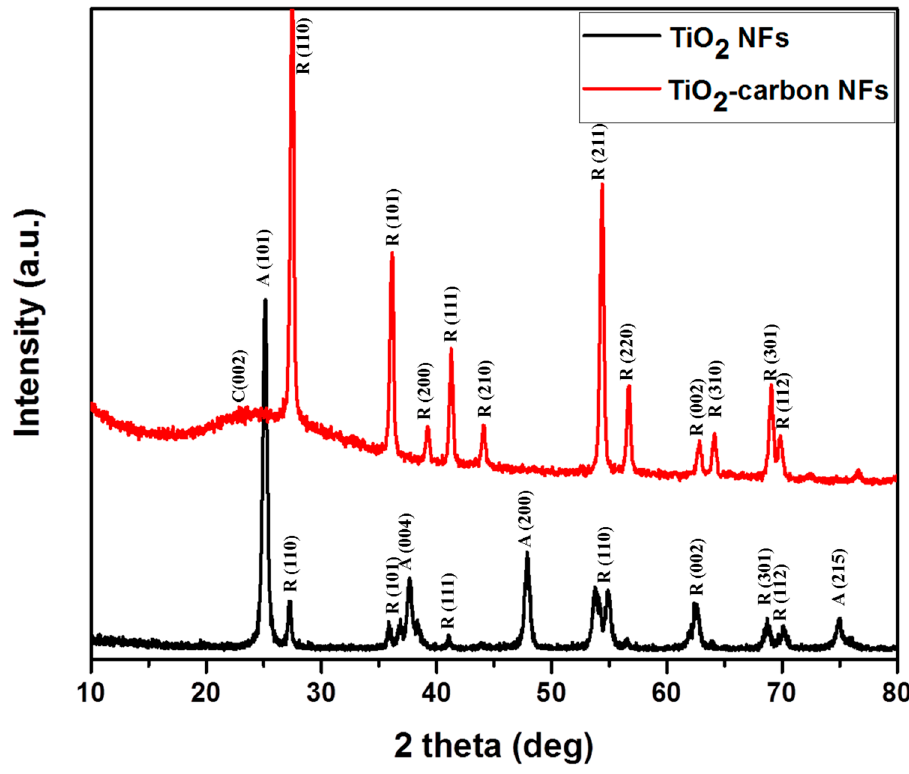
Figure 3. XRD spectra of as-synthesized TiO 2 -carbon NFs as compared to pristine TiO 2 NFs.